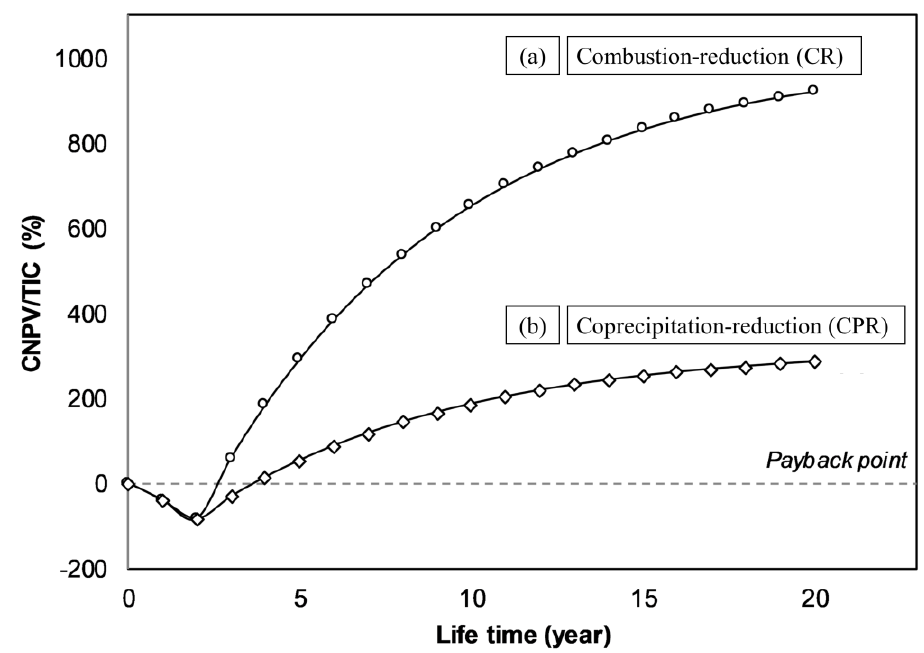
Fig. 2. Ideal condition in the production of LaNi 5 materials via (a) combustion-reduction (CR) and (b) coprecipitation-reduction (CPR) for CNPV/TIC (%) to life time (year) Table 3. Summary economic analysis reports of LaNi 5 using combustion-reduction (CR) and coprecipitation-reduction (CPR)